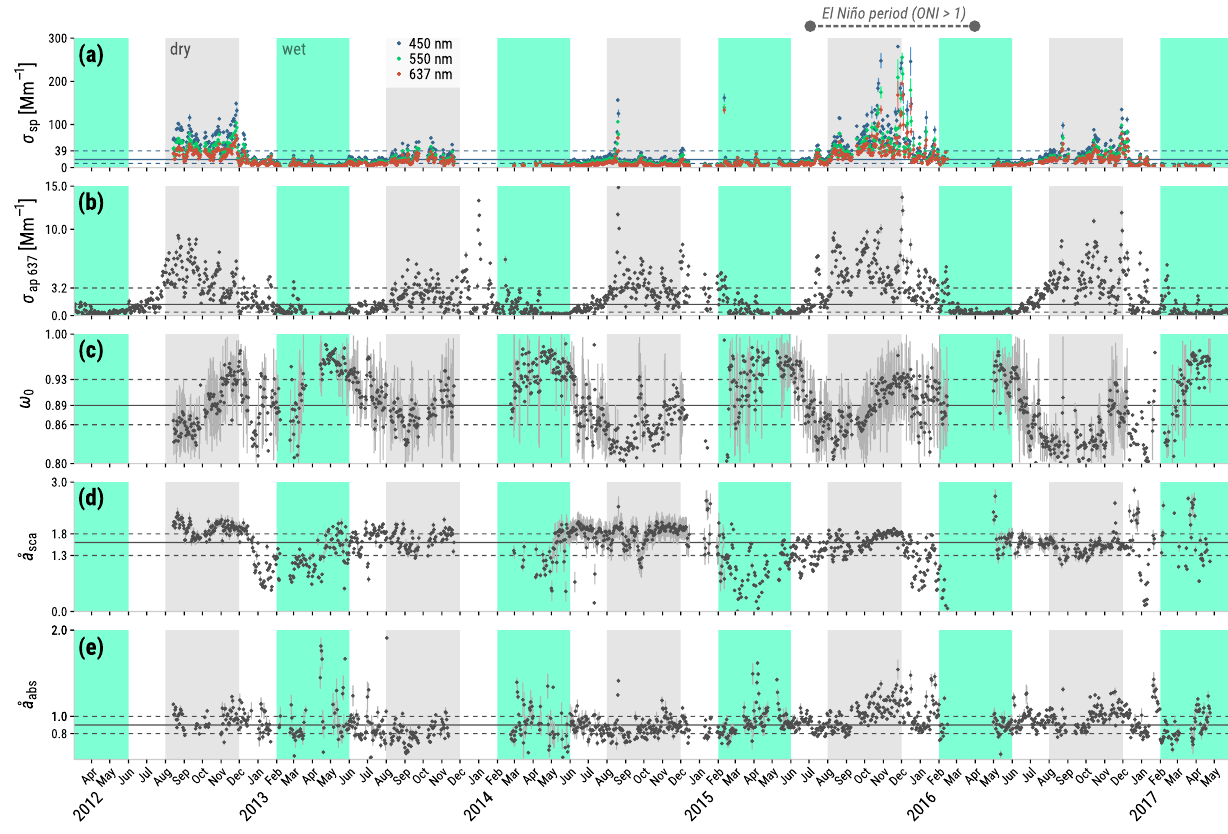
Figure 3. Overview of aerosol optical properties during the measurement period. (a) Scattering coefficient, (b) absorption coefficient at 637nm, (c) single scattering albedo at 637nm, (d) scattering Ångström exponent, and (e) absorption Ångström exponent. All data were averaged on 24h intervals and standard errors are presented as vertical gray bars. Green and gray shaded areas correspond to the wet and dry seasons, respectively. First and third quartiles are represented as horizontal dashed lines, and medians as horizontal solid